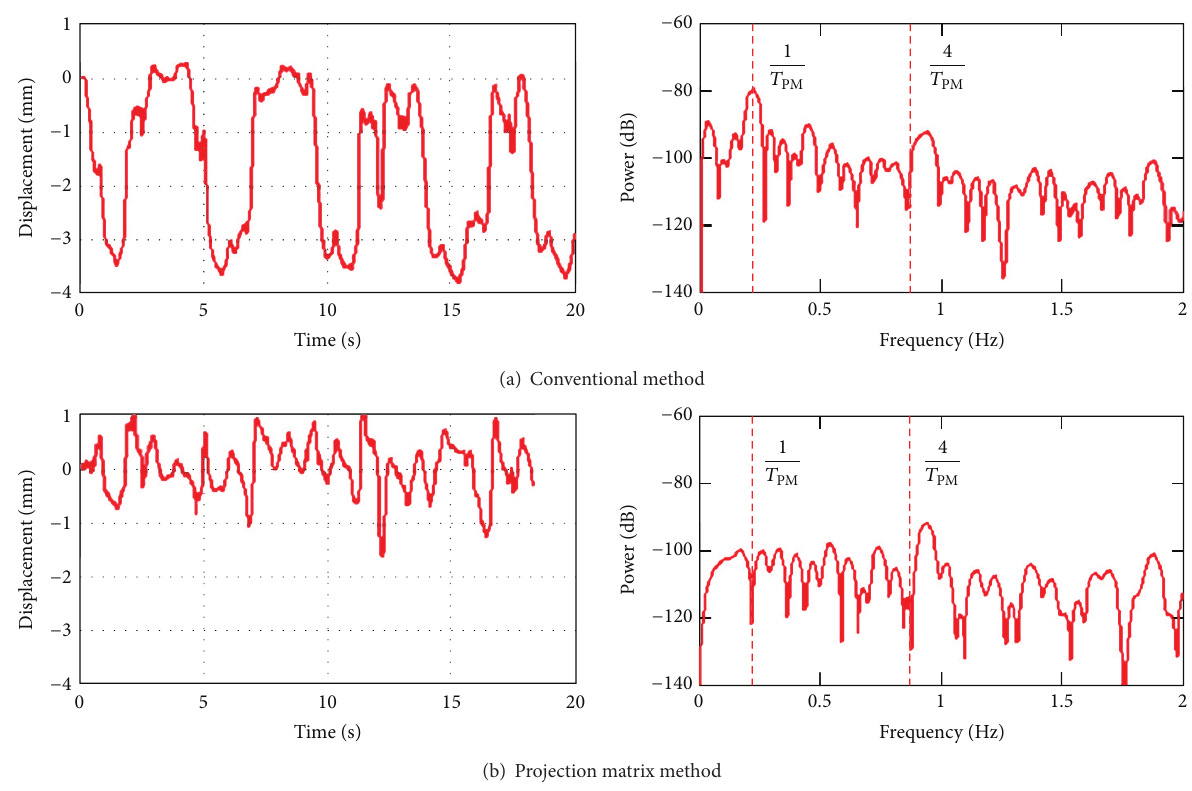
Figure 4: Signal processing results at the distance of 30cm.